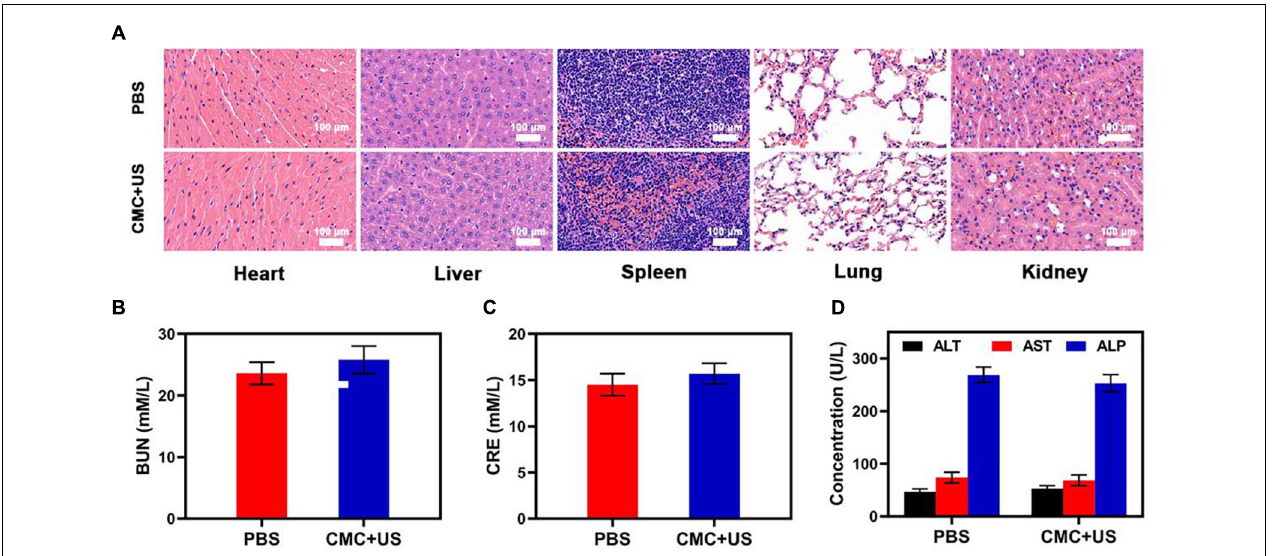
FIGURE 4 | (A) Histopathologic examination of the tissues including heart, liver, spleen, lung, and kidney from tumor-bearing mice after PBS or CMC + RT treatment. (B–D) Blood biochemistry data of kidney and liver function markers: BUN, CRE, ALT, AST, and ALP.